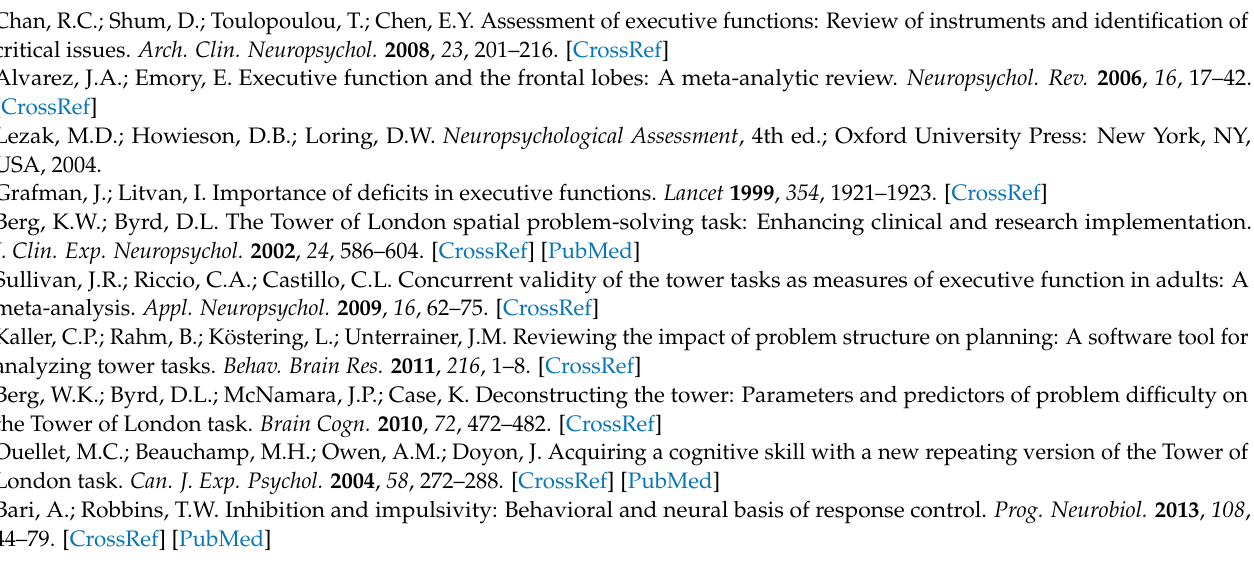
solution; Figure S2: Exploratory factor analysis for five TOL trials showed a 6-factor solution; Table S1: Performance in Tower of London (TOL) task for eight trials, across repeated measurements: Initial Thinking Time (ITT) and Execution Time (ET); Table S2. Significance of p value for three indicators of Tower of London (TOL): post hoc for main effect of “Trial”, and pairwise comparisons for main effect of “Time” and for interaction between “Time” and “Trial”; Table S3. Correlation matrix for Tower of London (TOL) and Go/No Go (GNG) task performance measures; Table S4. Performance in Tower of London (TOL) task for eight trials: Initial Thinking Time (ITT), Execution Time (ET), and Extra Moves (EM); Table S5. Factor loadings of Tower of London (TOL) and Go/No Go (GNG) task; Table S6. Factor loadings of five trials of Tower of London